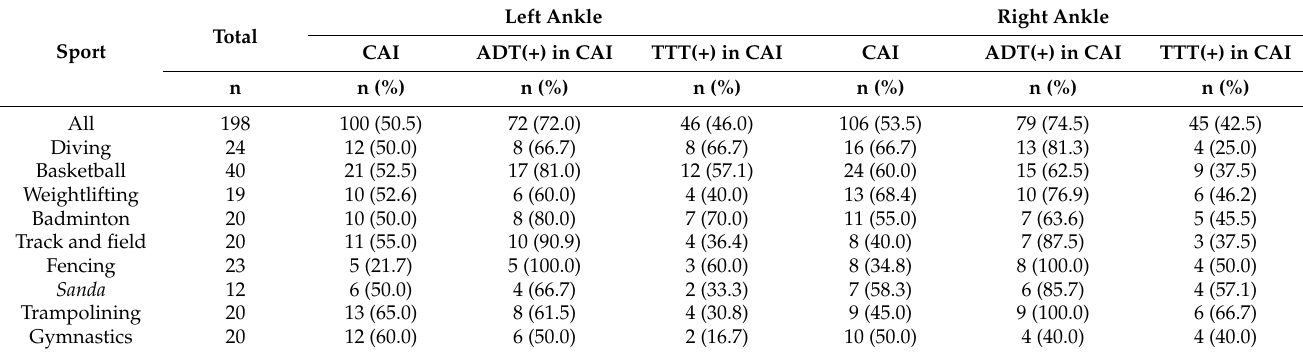
Table 5. The positive rate of anterior drawer tests and talar tilt tests for CAI